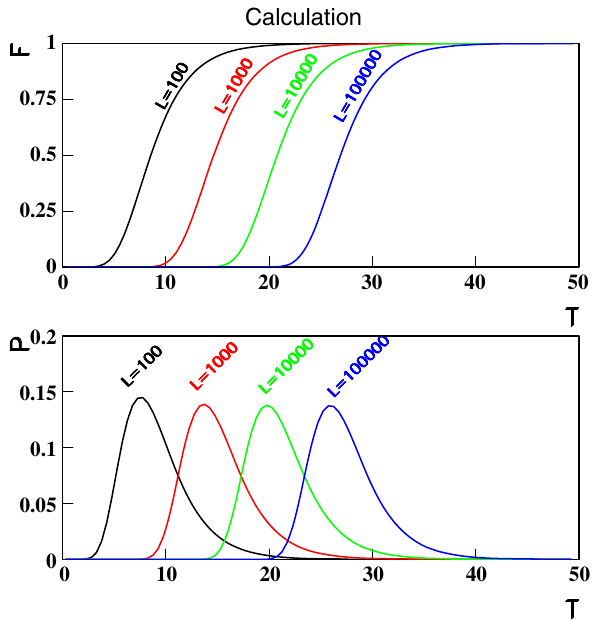
Fig. 3 Top: cumulative distribution, F ( T | L ) , for L = 10 2 , 10 3 , 10 4 , 10 5 . Bottom: probability density, P ( T | L ) , for the same